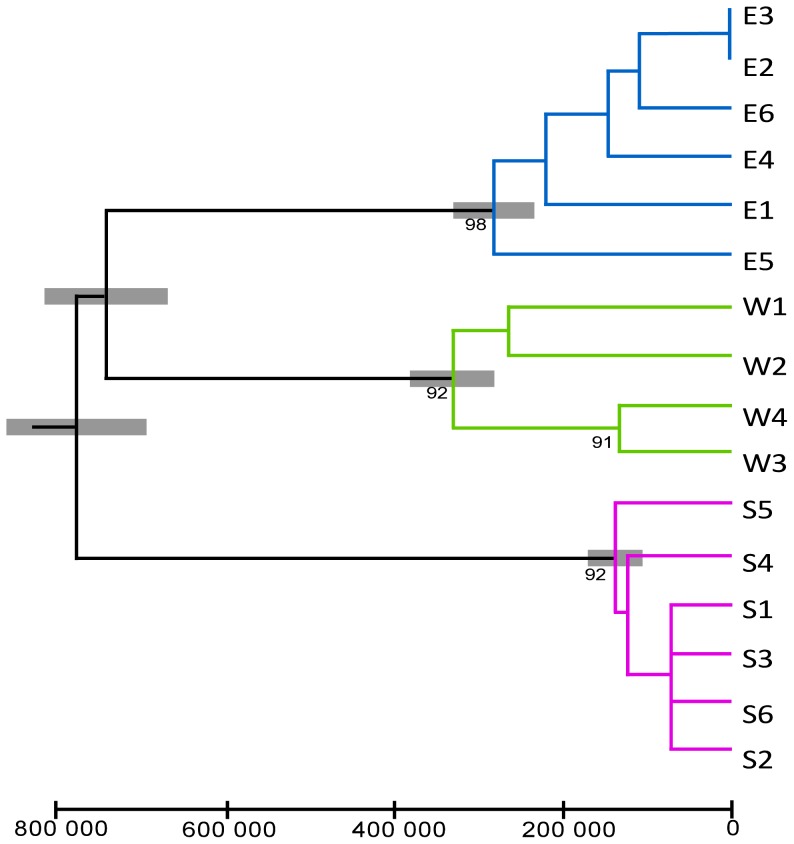
Chronogram of the main mtDNA lineages found in Discoglossus montalentii.Chronogram based on the NJ phenogram of the mtDNA haplotypes found in D. montalentii. Scale axis is in years. Bootstrap supports over 1000 pseudo-replicates of the NJ analysis are shown below the nodes (for supports >70%). Grey shading shows the standard deviations of the time estimates.